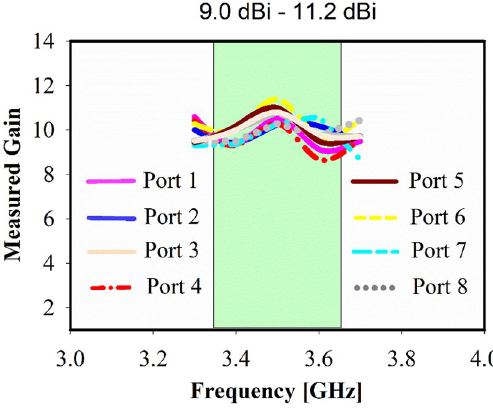
Figure 17. Gain of the mMIMO antenna: